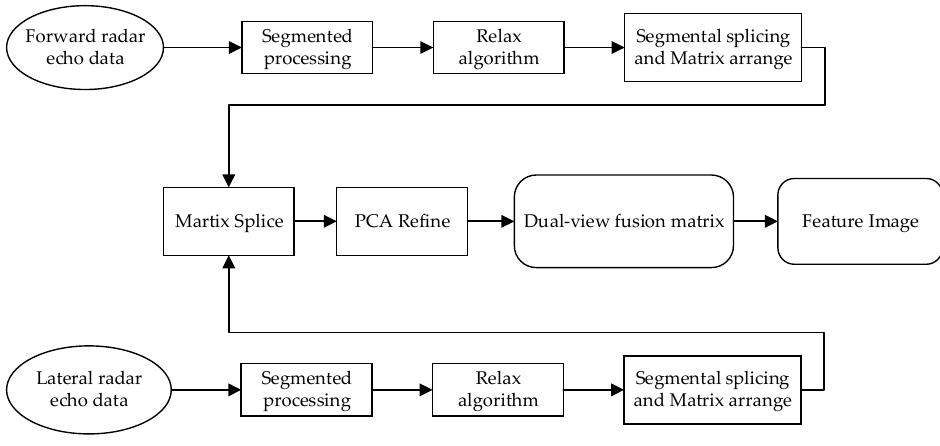
Figure 5. Fusion process of dual-view feature image.